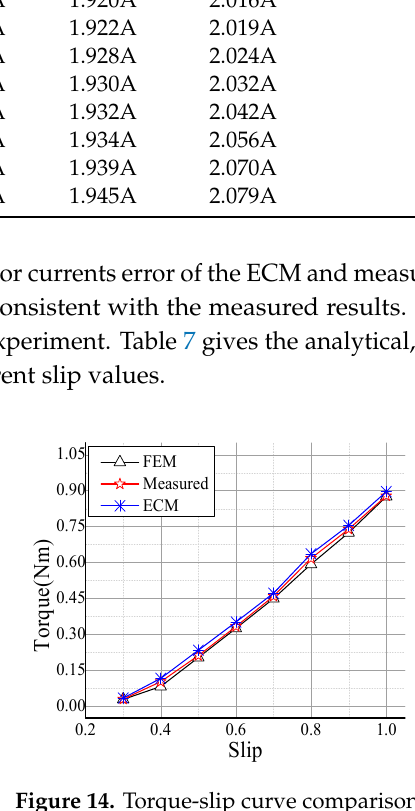
Figure 14. Torque-slip curve comparison.